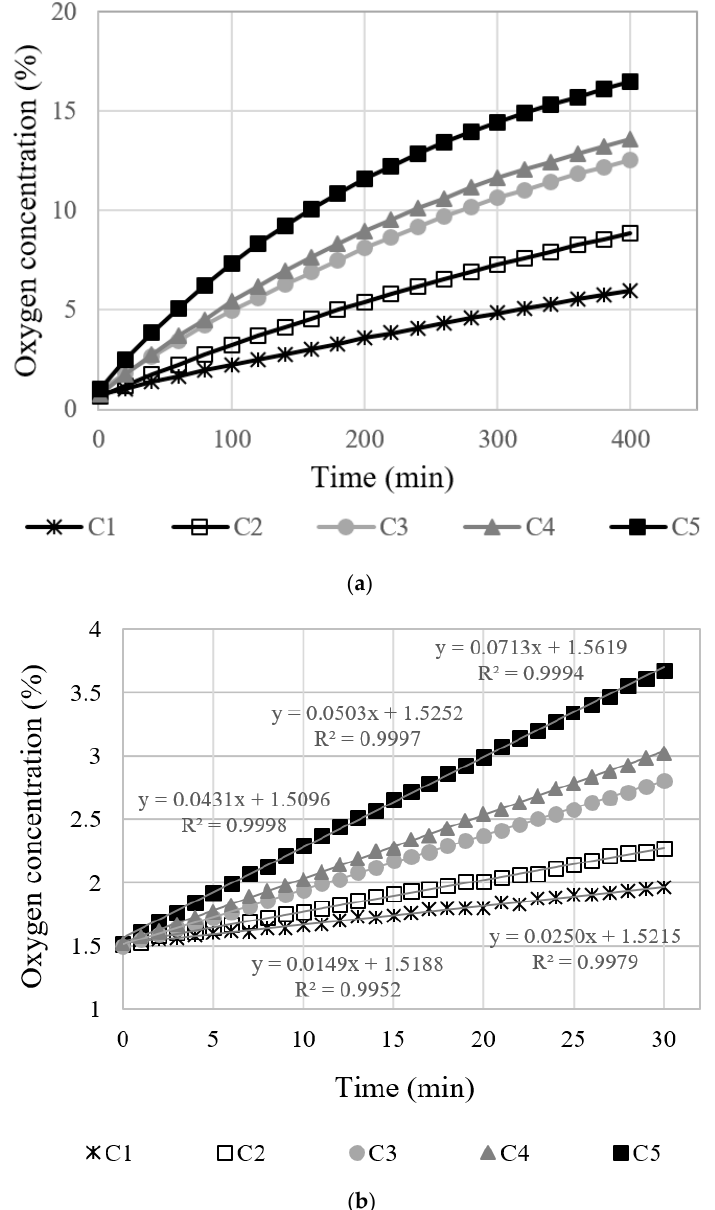
Figure 4. Oxygen concentration of C series specimens with respect to measuring time: ( a ) Overall measurements; ( b ) initial concentration 1.5%, measuring 30